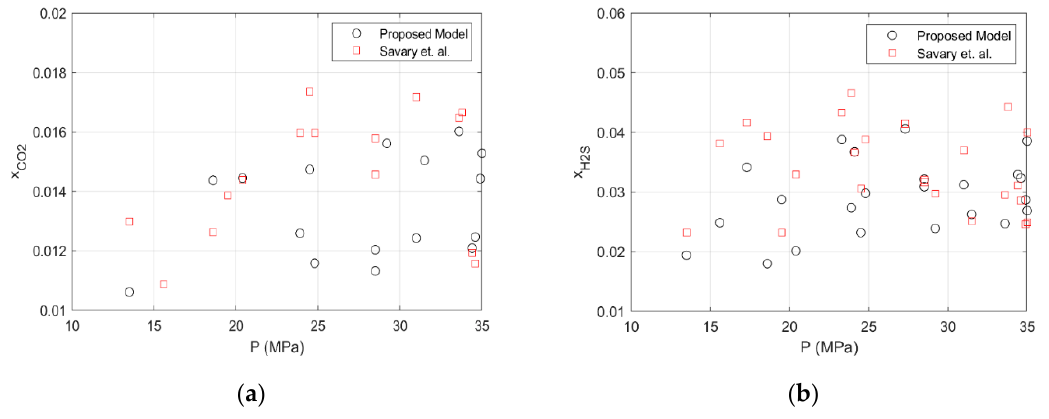
Figure 9. Validation of mixture solubility model 120 °C for CO 2 ( a ) and H 2 S ( b ).